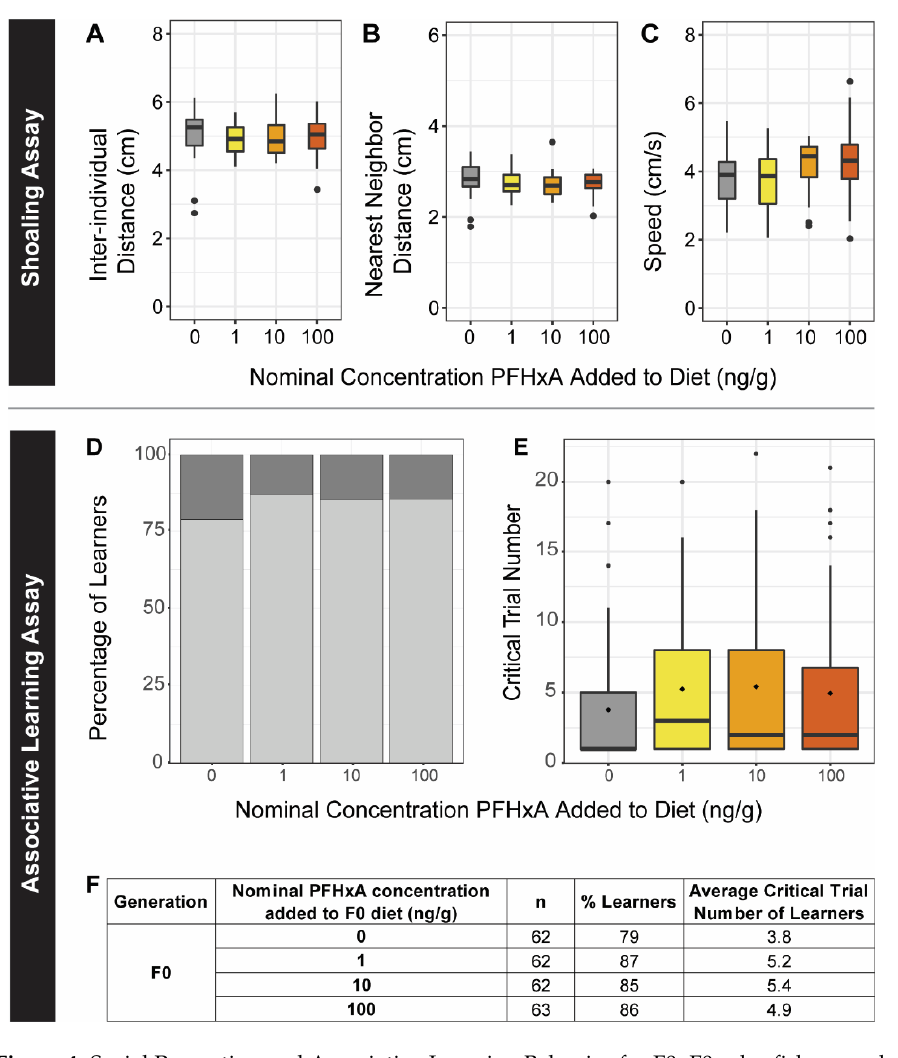
Figure 4. Social Perception and Associative Learning Behavior for F0. F0 zebrafish were challenged with adult behavior shoaling ( A – C ) and associative learning assays ( D – F ). Exposure groups are indicated on the x-axes and by color (left to right, grey: 0 ng/g, yellow: 1 ng/g, orange: 10 ng/g, and red: 100 ng/g PFHxA added to the diet). Dietary exposure did not alter social perception ( n = 64), as measured by inter-individual distance ( A ), nearest neighbor distance ( B ), or speed ( C ). Learning was also not impaired by PFHxA exposure, as measured by the percentage of learners ( D ) and critical trial number ( E ). Sample size, percent learners, and mean critical trial are presented in the table ( F ).